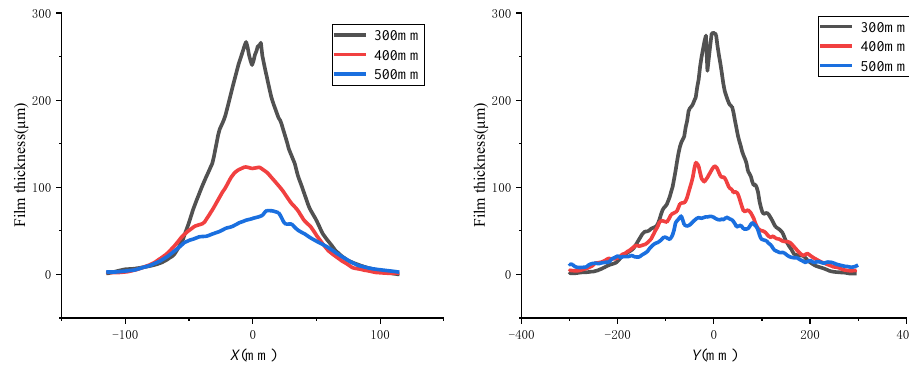
Figure 14. Film thicknesses at different spraying distances.